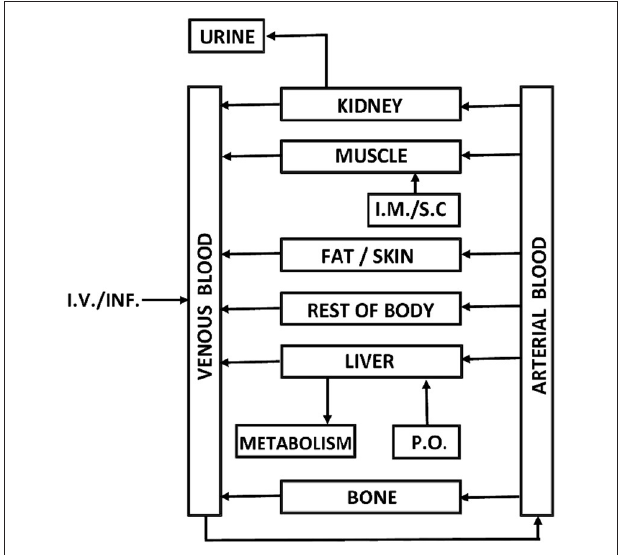
FIGURE 1 | Schematic representation of the PBPK model.